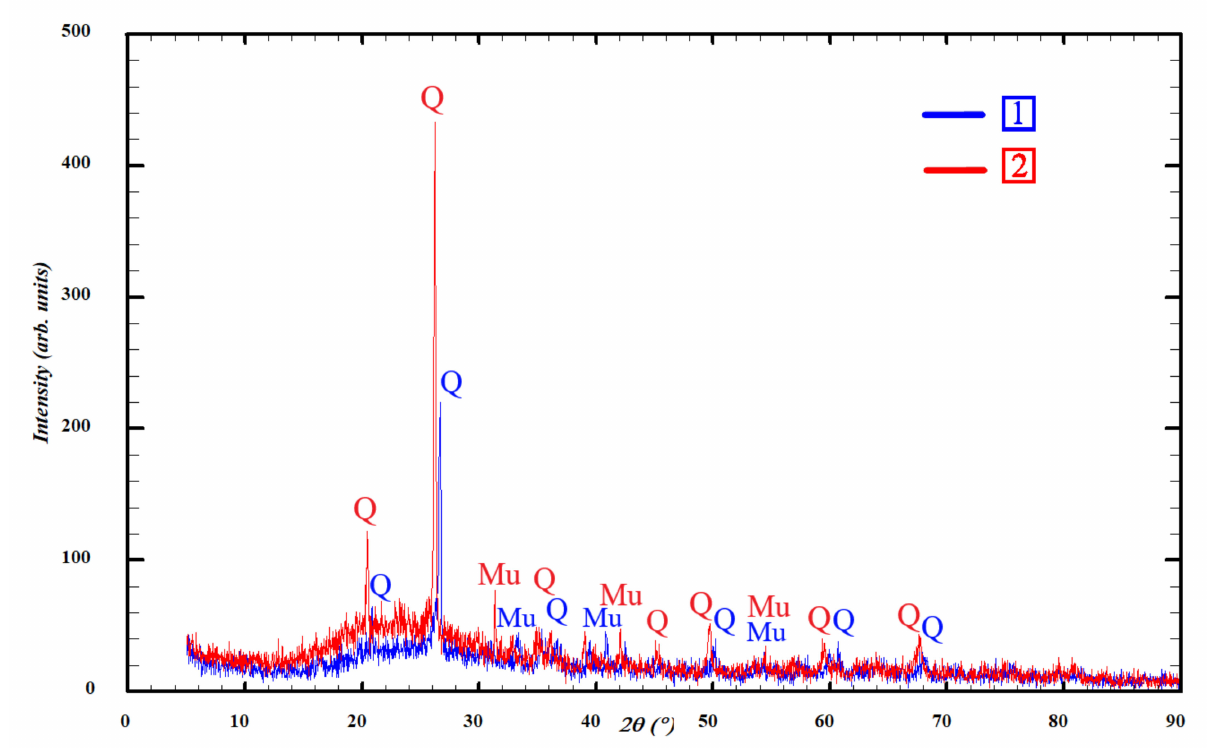
Figure 1. Results of X-ray analysis of ASW: 1—Apatitskaya CHPP; 2—Severodvinskaya CHPP-1; Q—high quartz,